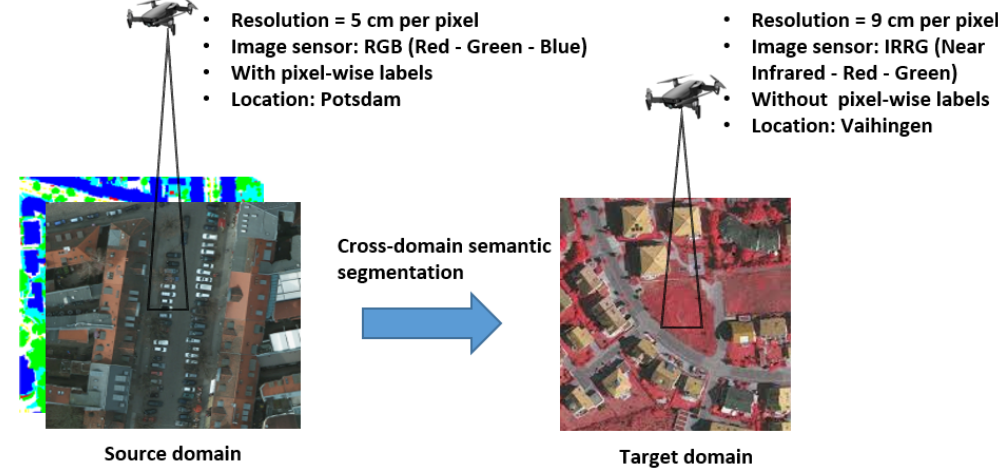
Figure 1. Cross-domains semantic segmentation of aerial